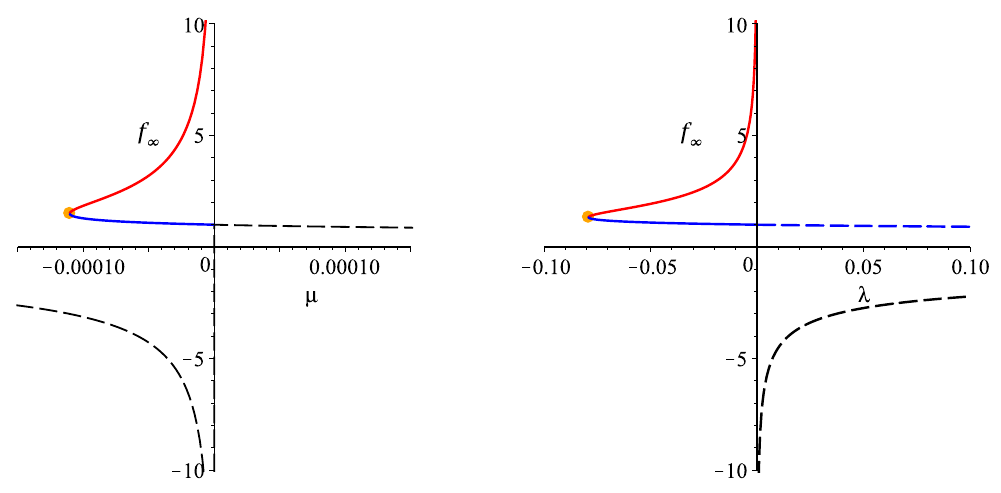
Figure 2 . Real possible values for f 1 in terms of coupling in four dimensions (color online). Left : the plot presents the real solutions to the equation (4.3) for di(cid:11)erent values of (cid:22) . The lower dashed black line corresponds to f 1 < 0, upper dashed black one depicts solutions with (cid:13) 2 < 0, and so is unstable. The red line, relates to existence of ghosts. Only the blue line is associated with a stable branch of solutions. The orange dot corresponds to the critical case (cid:22) c = (cid:0) ‘ 4 = 9072. Right : the plot denotes the real solutions to the equation (4.7) versus (cid:21) . The lower dashed black curve corresponds to f 1 < 0, upper dashed blue line depicts unstable solutions with (cid:13) 2 < 0. The red line shows the appearance of a ghost solution. The blue solid line corresponds to stable branch of solutions. The orange dot denotes the critical case (cid:21) c = (cid:0) 81 ‘ 6 = 1024. In both plots we have set ‘ =